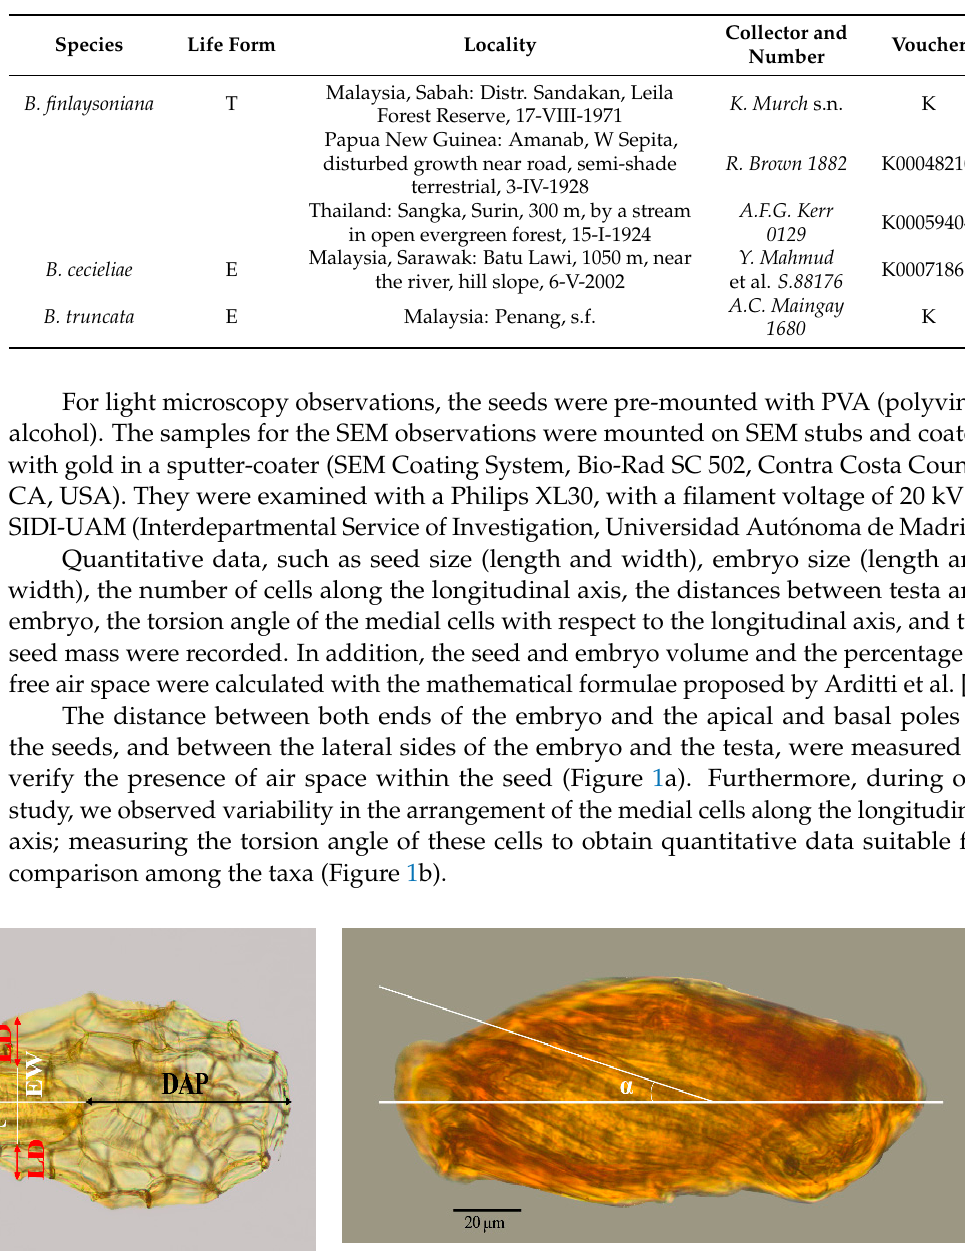
Table 1. List of species studied with life form (E: epiphyte; T: terrestrial), localities, collector (including collector number) and voucher.